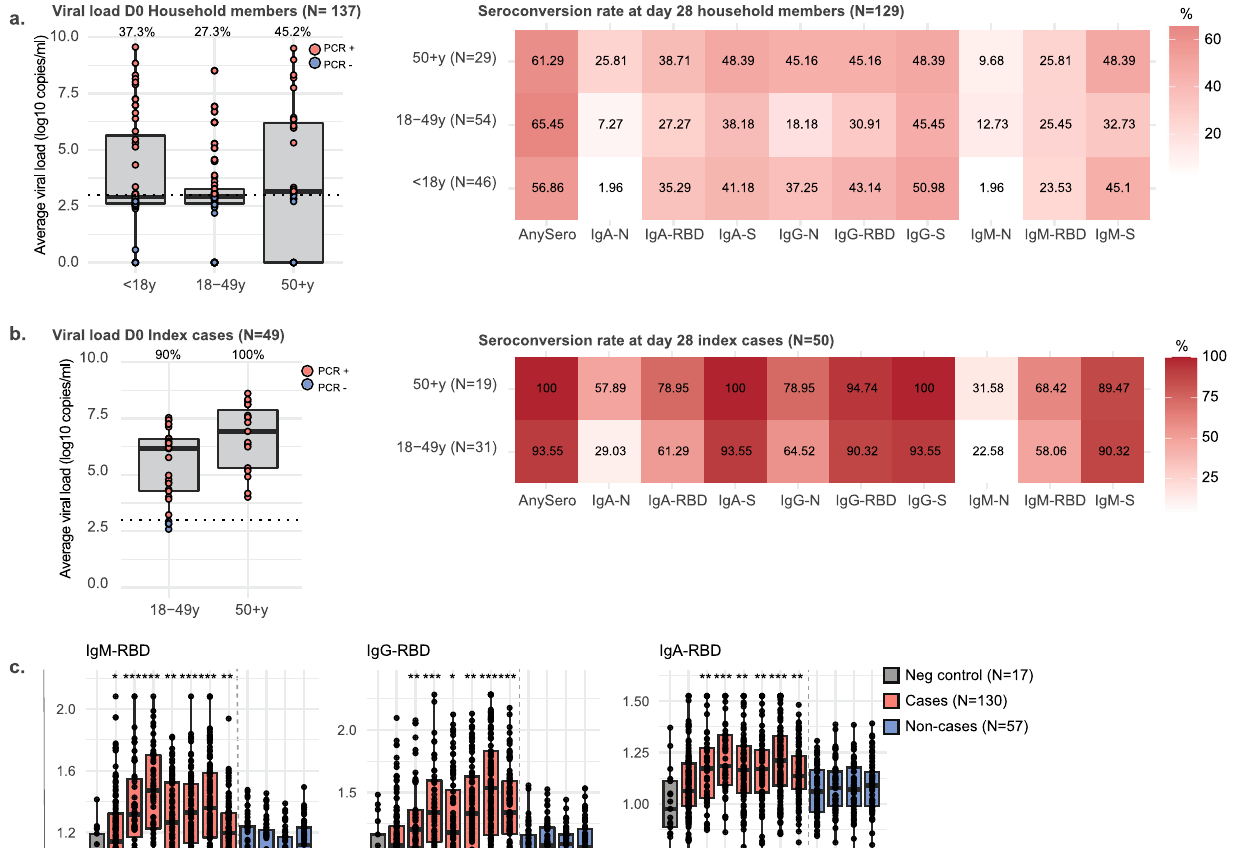
The magnitude of serum antibody levels in the index and contact cases did not differ between the three age groups, except for anti-N IgA and IgG, which were signi fi cantly higher in the ≥ 50 years old (Supplementary Fig. S2a). To examine the correlation between nasal and serum antibody levels in cases, we focused on the day-28 and 9-month timepoints. For